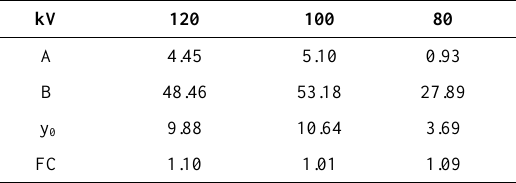
Table 1. Proportionality constants for calibration